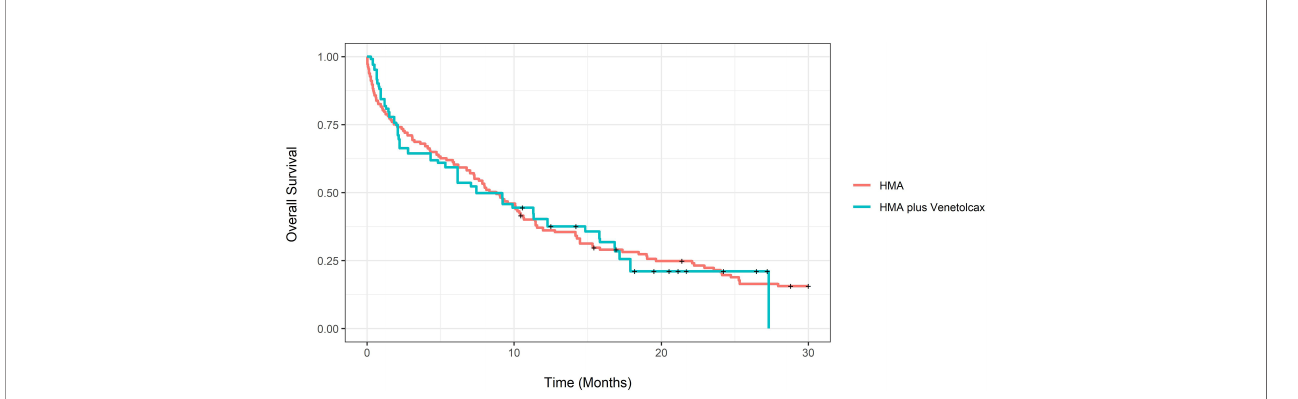
FIGURE 3 | Propensity score-adjusted overall survival for newly diagnosed acute myeloid leukemia patients treated with hypomethylating (HMA) vs. HMA plus venetoclax.